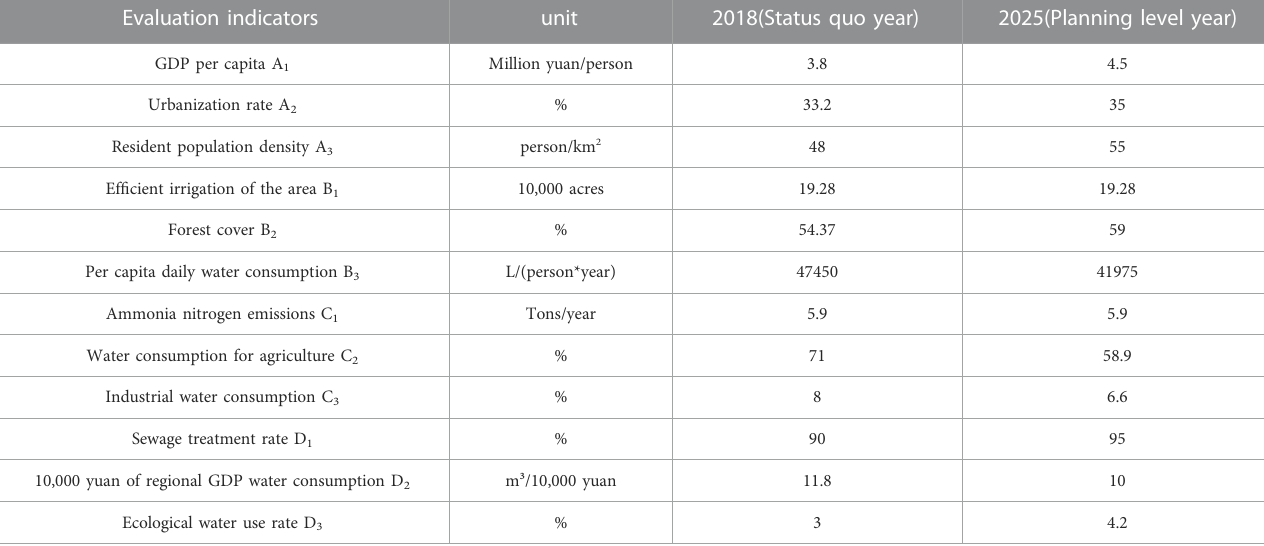
TABLE 11 The annual evaluation index values of the current situation and planning level of Chicheng County.